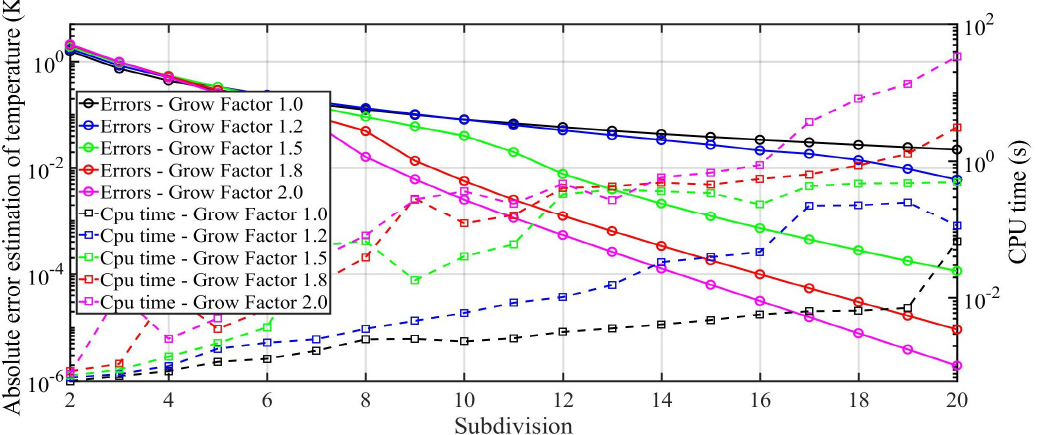
Figure 8. Absolute maximum temperature error estimations of the inner wall surface (Case 1).